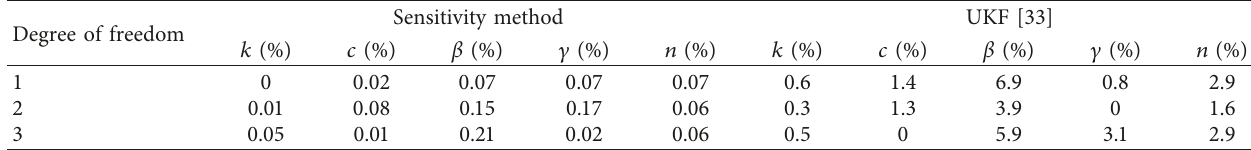
, (b) c , (c) β , (d) c , and (e) n and (f) a comparison of the identified load with the true load. 1 1 1 1 1 Table 8: Identified errors using the sensitivity method and UKF [33]. Sensitivity method